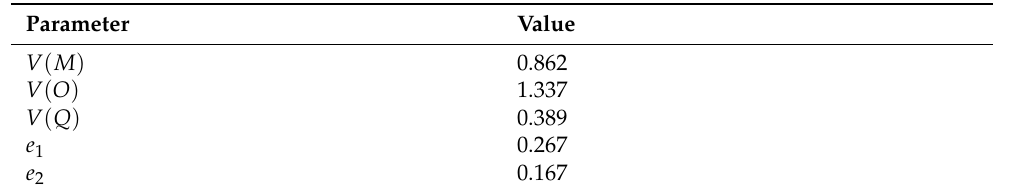
Table 4. Basic parameters. Currency: US$ Unit: million dollars.